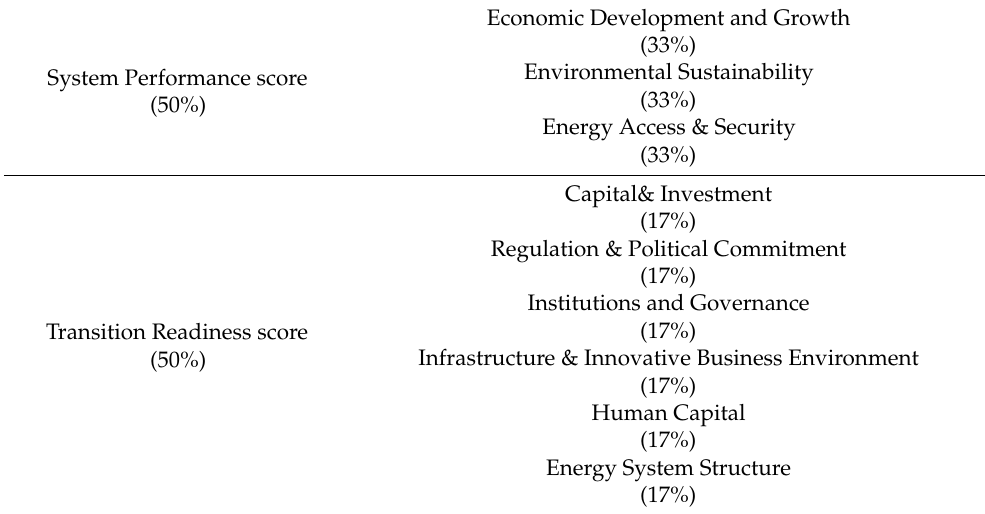
Table 2. Dimensions and variables of the Energy Transition Index (ETI).